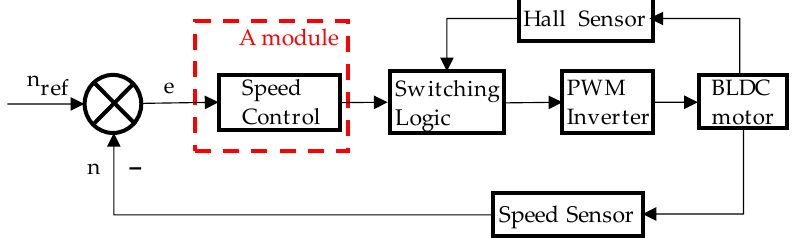
Figure 1. Block diagram of the control system of BLDC motor.